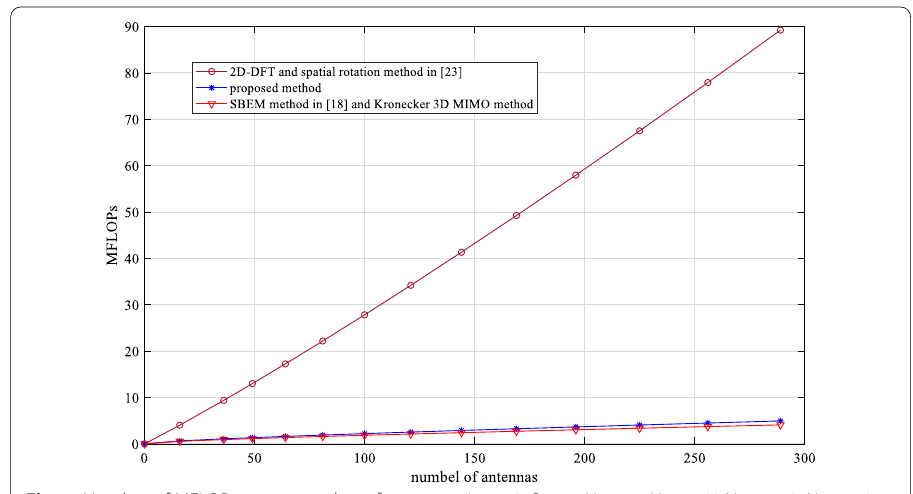
Fig. 4 Number of MFLOPs versus number of antennas, L = 16 , G = 4 , N g = 4 , N ro = 60 N co = 10 , N b = 10 . Shows the comparison of different algorithm computational complexity. Curve of the number of MFLOPs changes with the number of